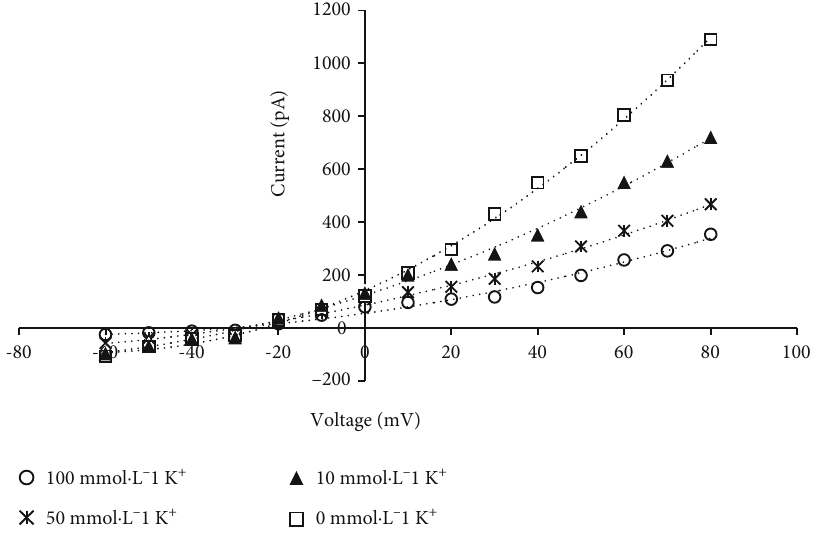
Figure 6: Curves of the current-voltage relation in response to di ff erent extracellular K + concentrations via patch clamp system. Green fl uorescence-labeled HEK293-T cells were selected and being detected by PCLAMP 10.0 device. The current signal of the SpuSKOR channel was collected by PCLAMP 10.0 and then being analyzed via the Sigmaplot 10.0 software. The external K + concentration in the extracellular fl uid was set of 0, 10, 50, and 100mmol · L -1 . Data are shown as the means of values obtained from 6 independent